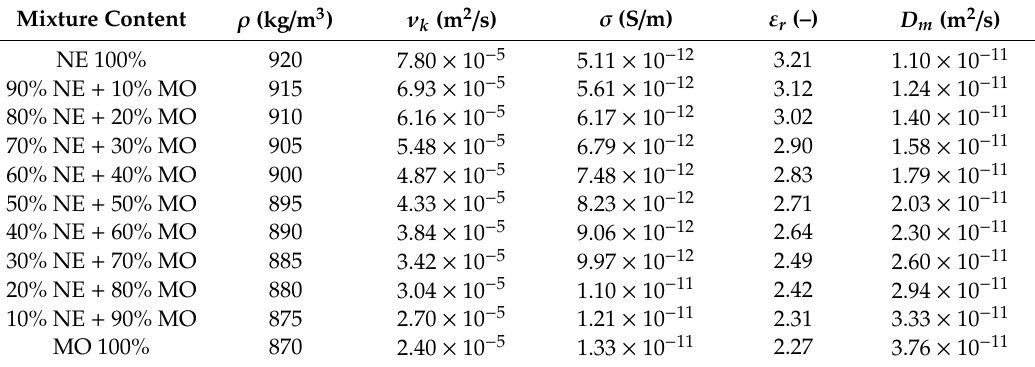
Table 2. Properties of Envirotemp FR3 natural ester and aged Trafo EN mineral oil mixtures (20 ◦ C). Mixture